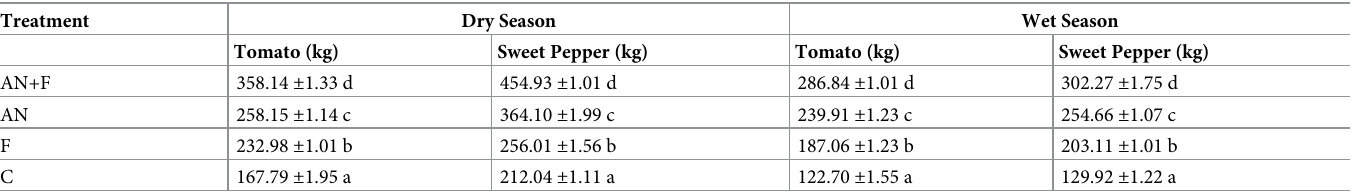
Different letters denote significant differences at 95% confidence levels according to Fisher’s protected LSD.